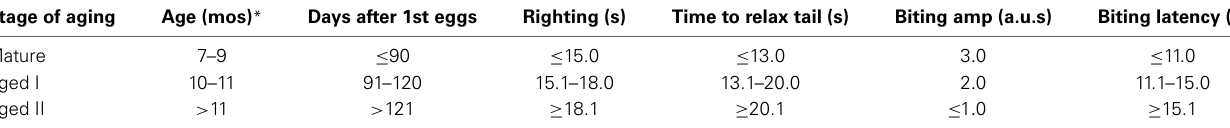
significantly with age ( p ≤ 0 . 01; 2-sample t -test). (C) The number of EPSPs evoked for up to 5s following tail shock also decreased significantly with age ( p ≤ 0 . 001; n = 21 for M, n = 27 for O). ∗∗ and ∗∗∗ denote significant difference from mature at p ≤ 0 . 01 and p ≤ 0 . 001, respectively.